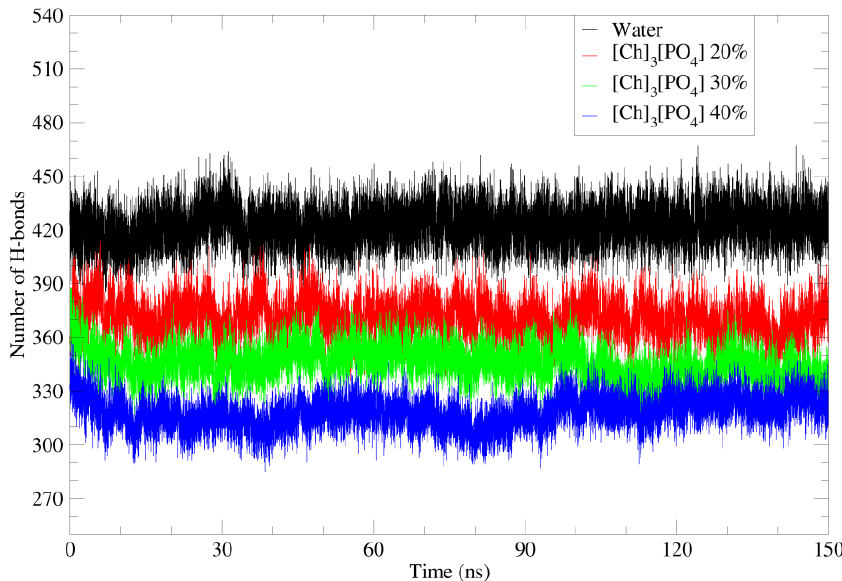
Figure 8. Number of hydrogen bonds of water and cholinium phosphate with amino acids of PETase in 40%, 30%, and 20% IL solutions. (A) Pure water in black; 20% of [Ch] 3 [PO 4 ] in red; 30% of [Ch] 3 [PO 4 ] in green and 40% of [Ch] 3 [PO 4 ] in blue.